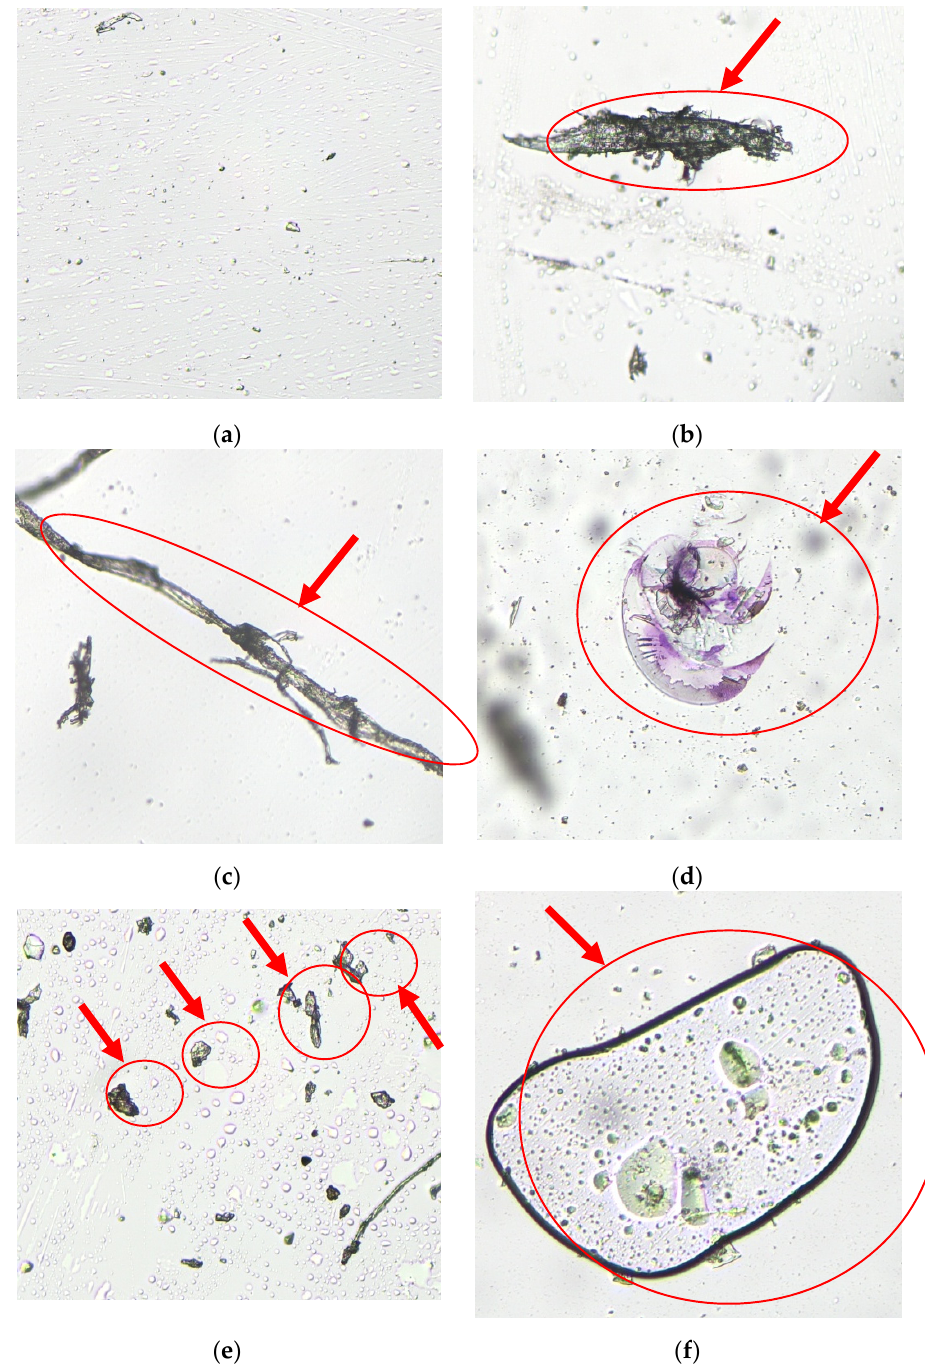
Figure 2. The microscopic examination of the syrups: ( a ) Syrup 11; ( b ) Syrup 01; ( c ) Syrup 02; ( d ) Syrup 03; ( e ) Syrup 10; ( f ) Syrup